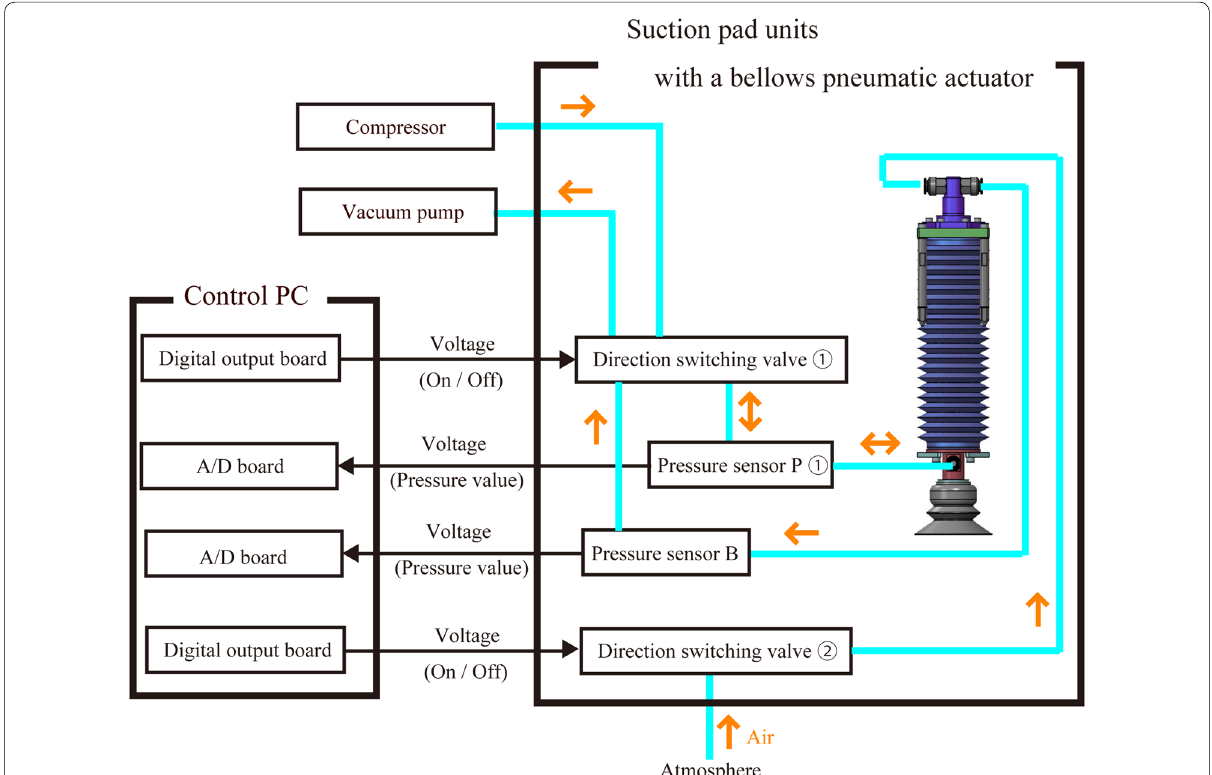
Fig. 12 System configuration of suction pad units with a bellows pneumatic